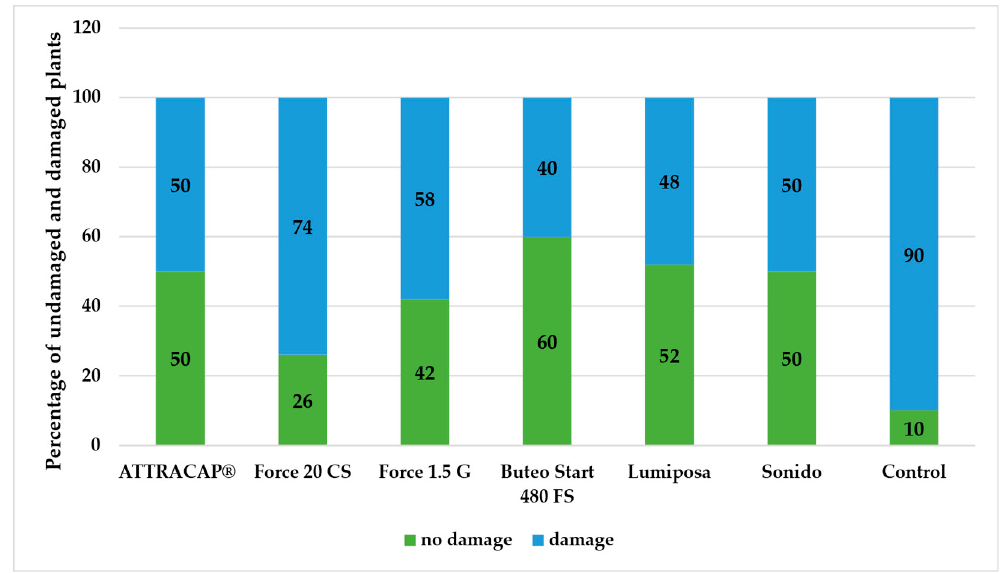
Figure 5. Percentage of undamaged and damaged plants in different insecticidal treatments in the sunflower field RŠ Field 1 in the year 2021.